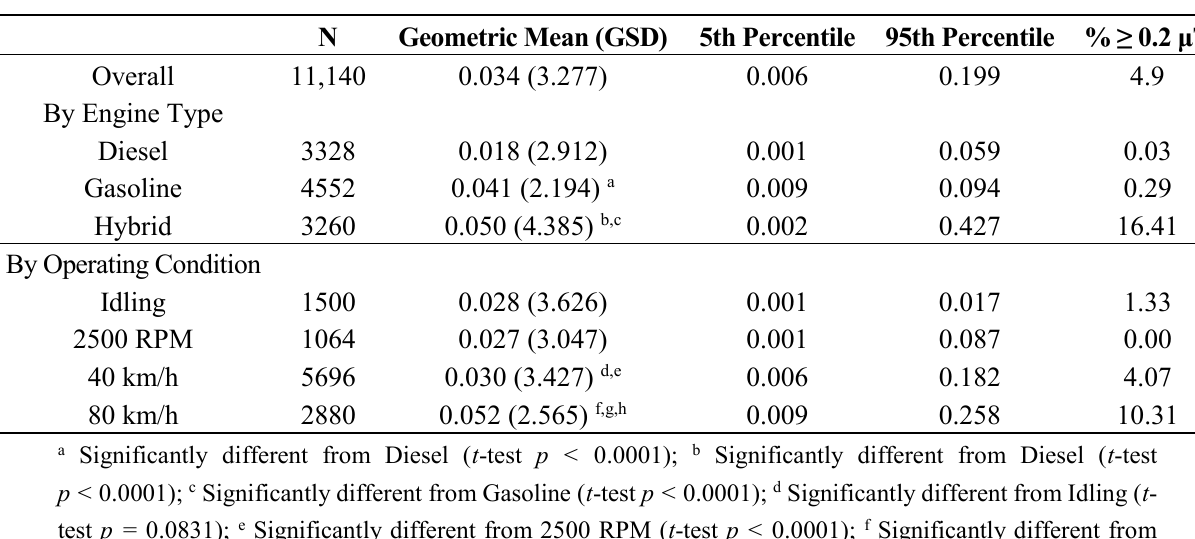
Figure 2. Ratio of geometric means (1st run/2nd run) for 40 km/h and 80 km/h repeated runs, sorted from low to high. Table 2. Descriptive statistics for magnetic field measurements (μT) overall and by operating condition and engine